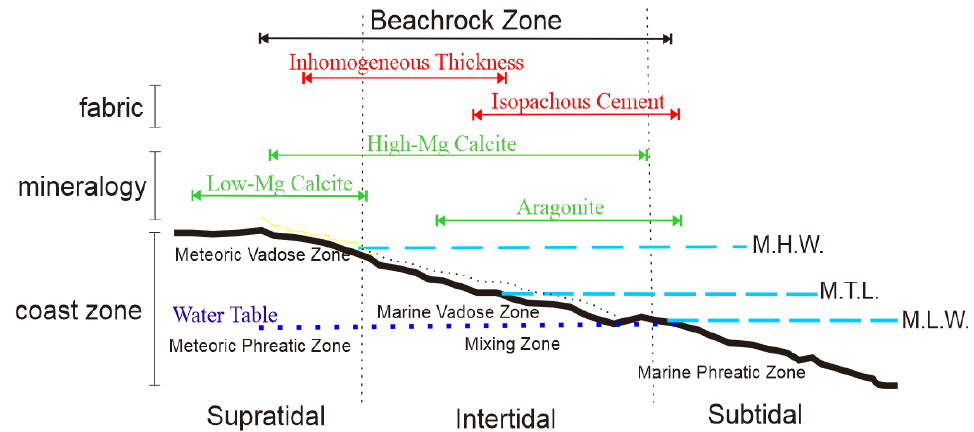
Figure 6. Schematic illustration of coastal zones, cement fabrics, and mineralogy-formation environments of the beachrocks (M.H.W: high water level, M.T.L: mean tidal water level, M.L.W: low water level).